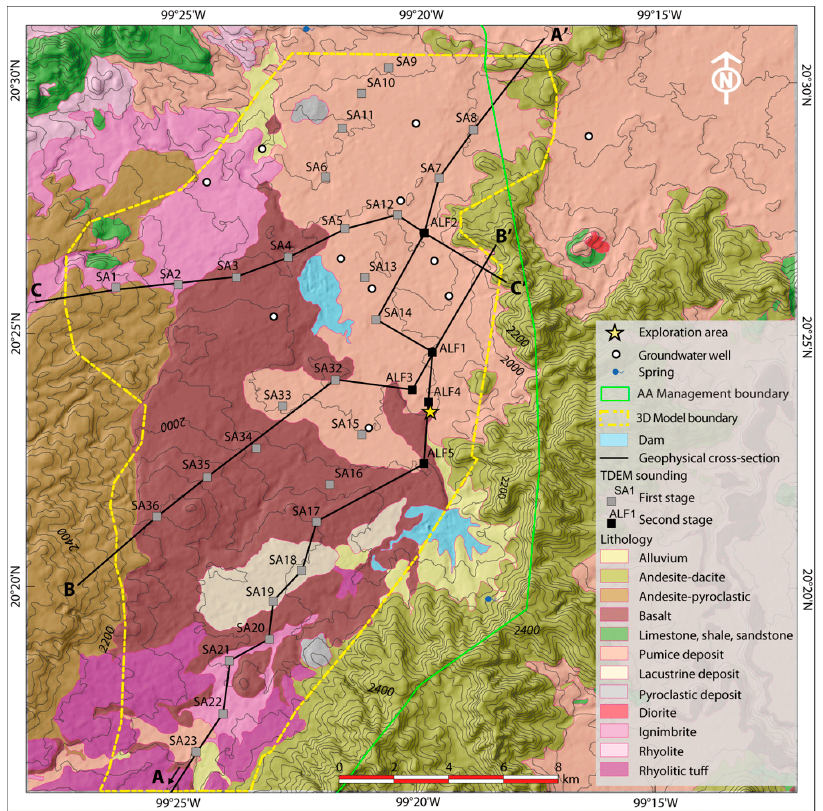
Figure 2. Geological map of the study area, adapted from [53]. AA: Alfajayucan aquifer. The 3D model boundary (in yellow) is shown in Section 3.6.